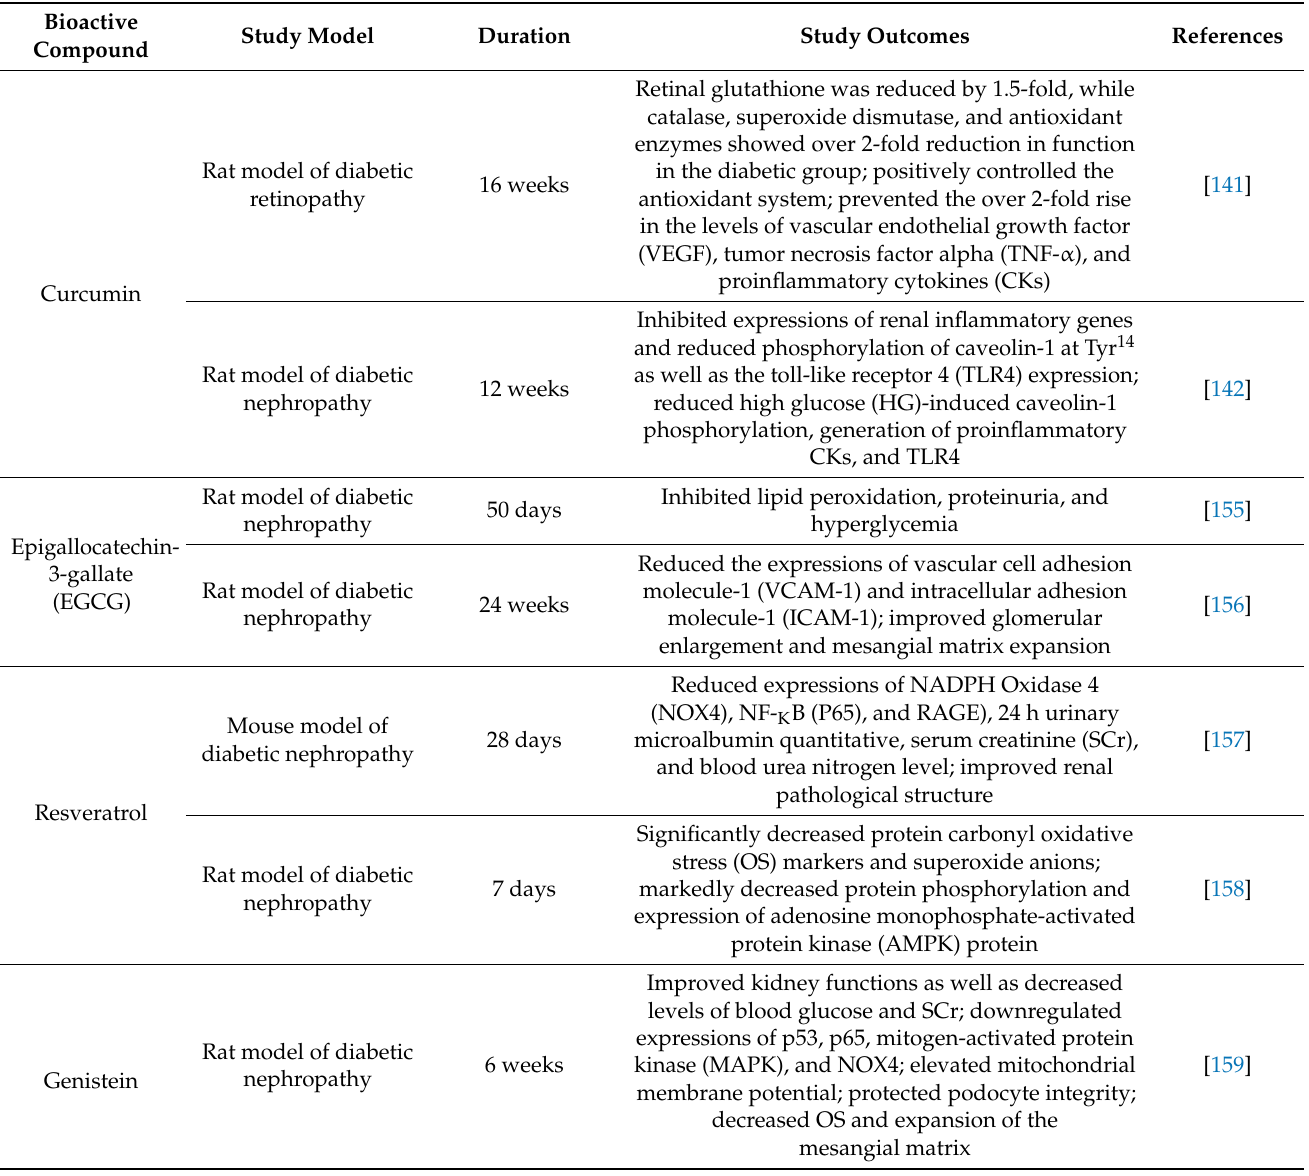
Table 2. Anti-inflammatory effects of bioactive compounds in animal models of diabetic macrovascu- lar